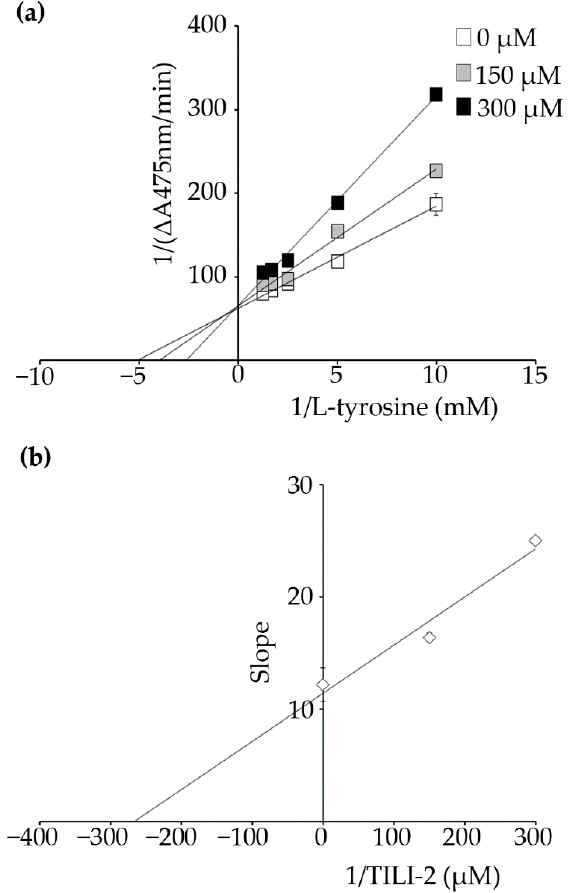
Figure 2. Kinetic study of TILI-2 reveals it is a competitive inhibitor. ( a ) Lineweaver-Burk plots with TILI-2 at a range of concentrations from 0 to 300 µM. ( b ) Secondary plot of Lineweaver-Burk plot. K i was obtained from the plot of slope versus TILI-2 concentration.